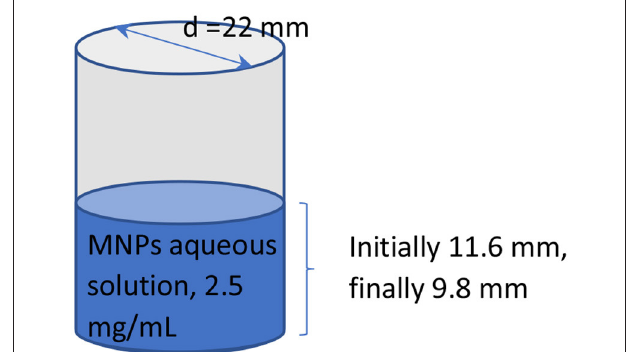
FIGURE 7 | Schematic of the sample solution.